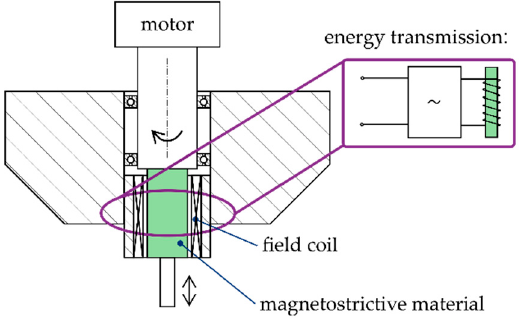
Figure 3. Principle design of a magnetostrictive system for ultrasonic assisted milling.